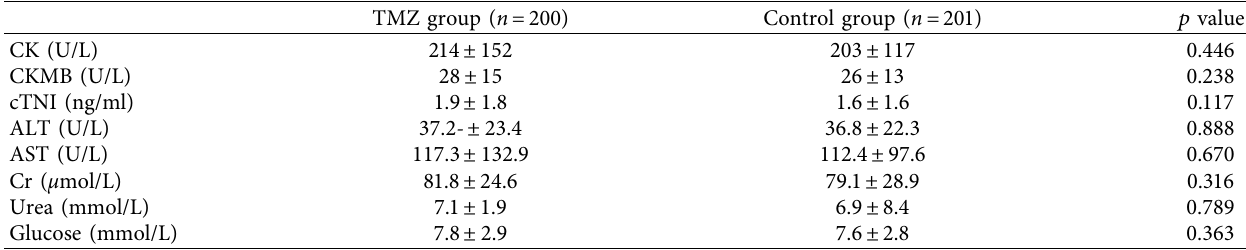
Table 3: Baseline laboratory data at